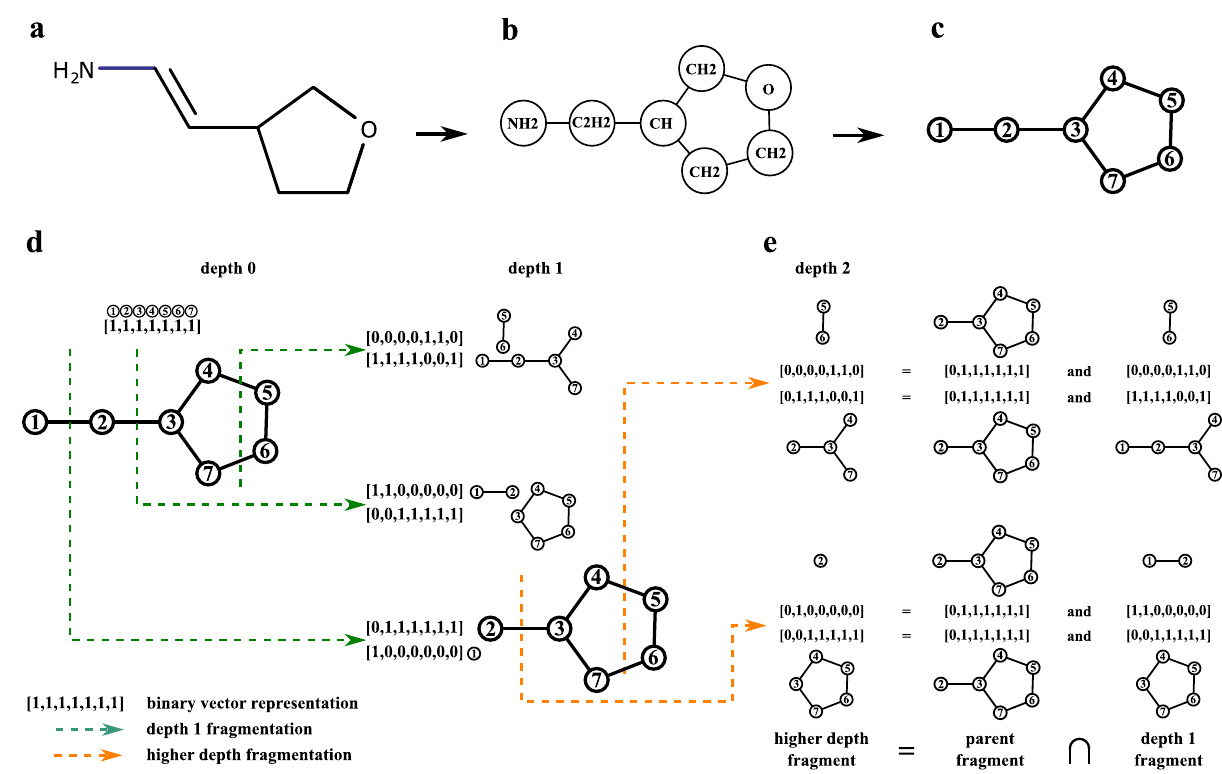
Fig. 8 Overview of fragmentation graph construction algorithm. a A small molecule. b Metabolite graph of the molecule. c Indexed metabolite graph. d Construction of the fragmentation graph of the small molecule. We assign an index to each component of a molecule and represent each of its fragments as a binary vector, where 1 and 0 indicate presence and absence of the components. Each bridge/2-cut of a parent fragment gives two child fragments. e Higher depth fragments can be computed as overlaps of their parents with the depth one